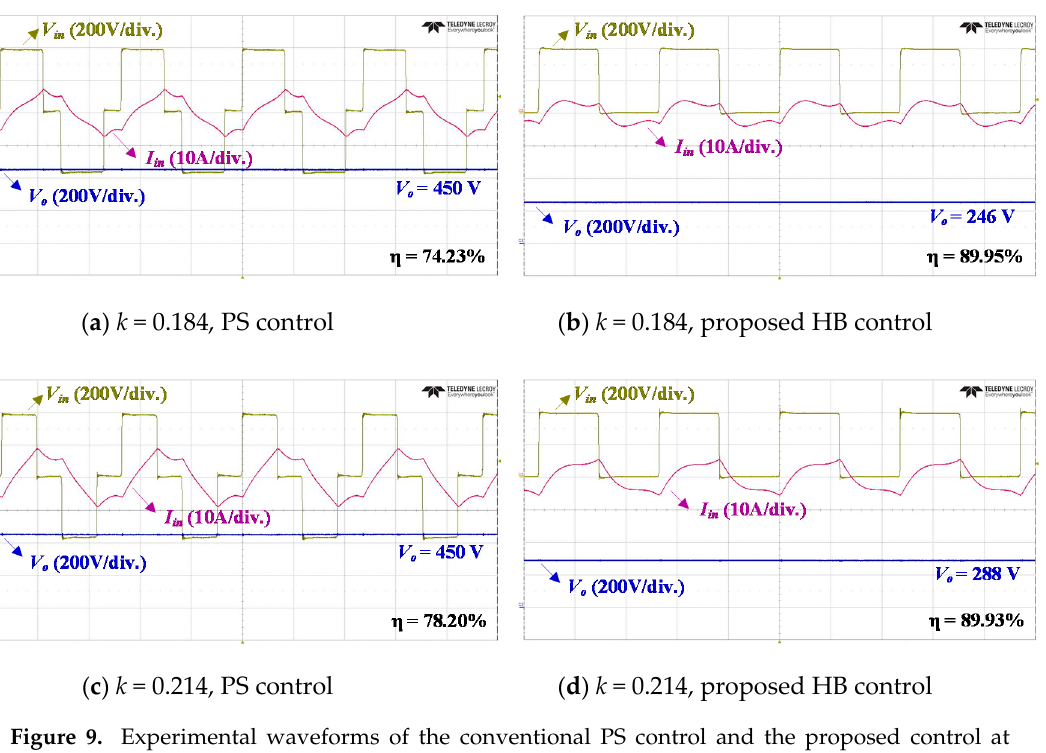
Figure 9. Experimental waveforms of the conventional PS control and the proposed control at P batt = 400 W.